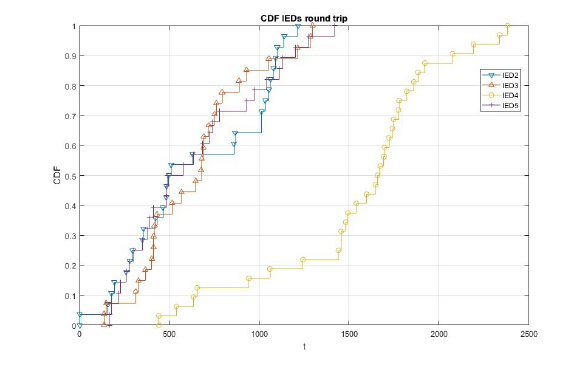
Figure 11: Probability CDF for the DMS IED1- DMS IEDs clients’ round trip time